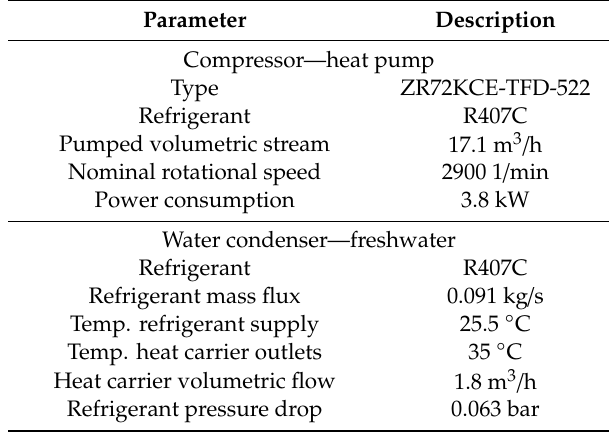
Table 2. Selected technical parameters of installed devices.